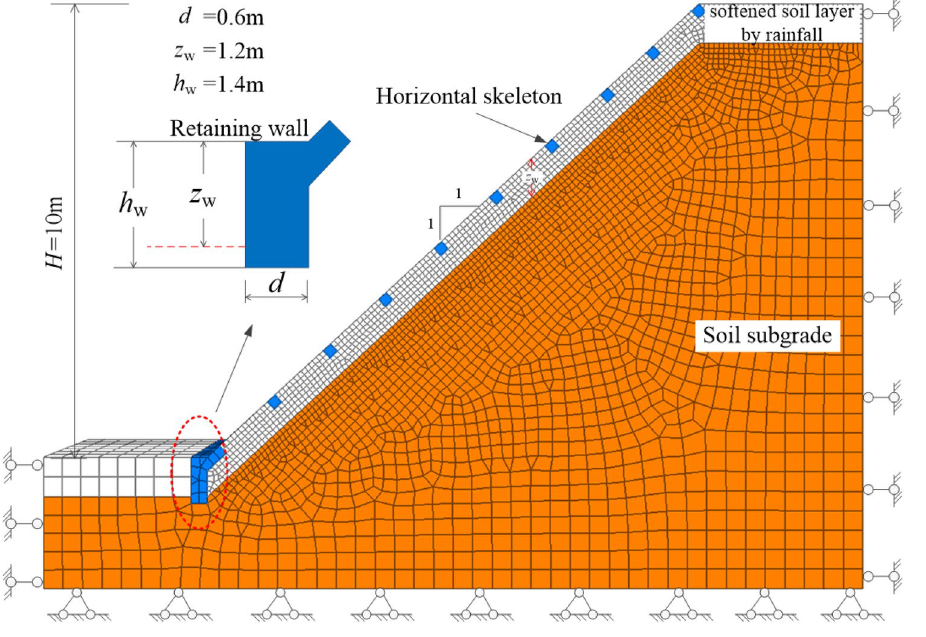
Figure 5. Plan view of the numerical